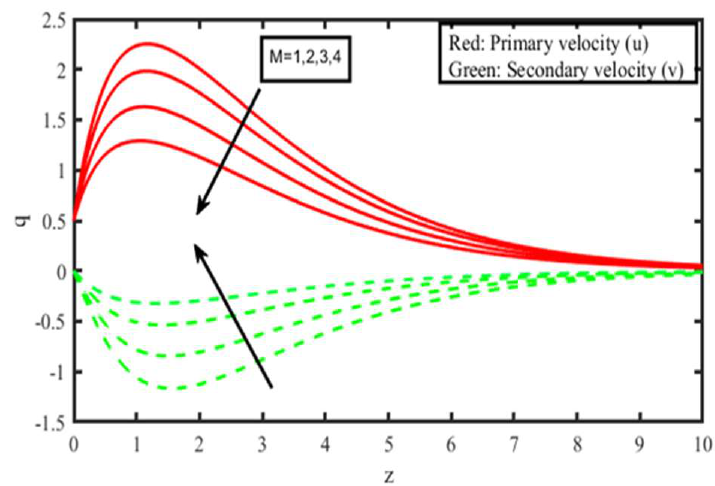
Figure 4. Velocity profiles for u and v for Magnetic field parameter (M).